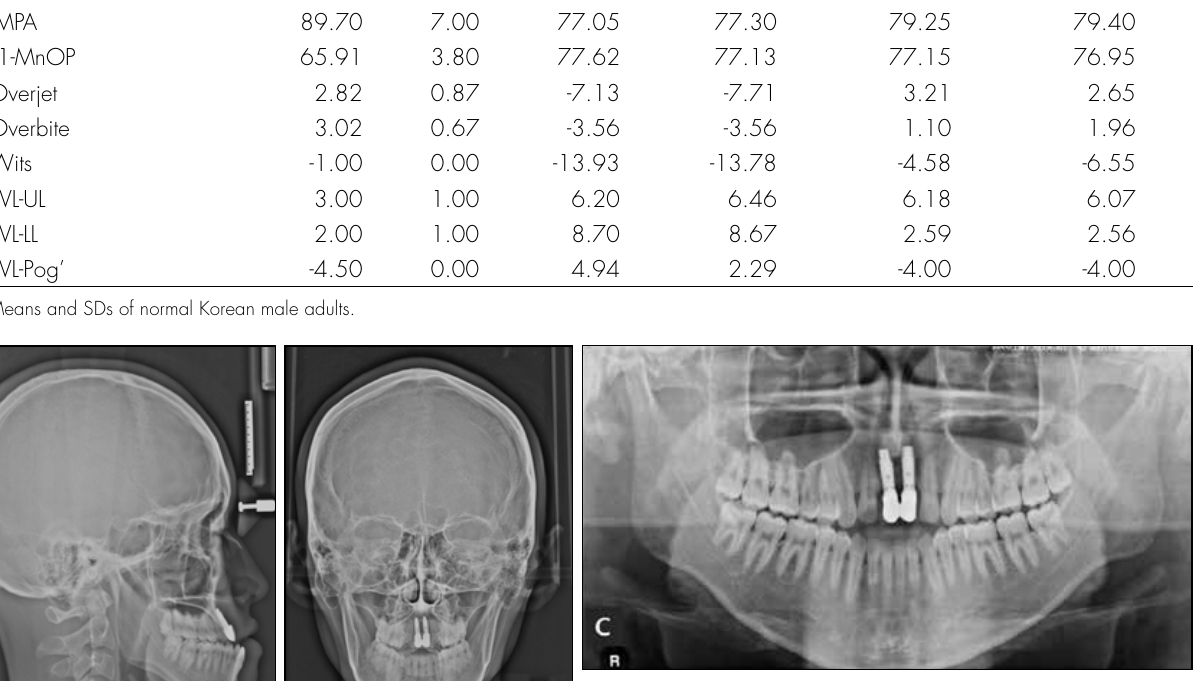
Figure 2. Pretreatment radiographs. A, lateral cephalogram; B, posterio-anterior cephalogram; C, panoramic radiograph. high mandibular plane angle, and a dental Class III malocclusion with an anterior open-bite. Treatment progress and results Treatment was initiated according to the treatment objectives and treatment plan (Table II). Fixed pre-